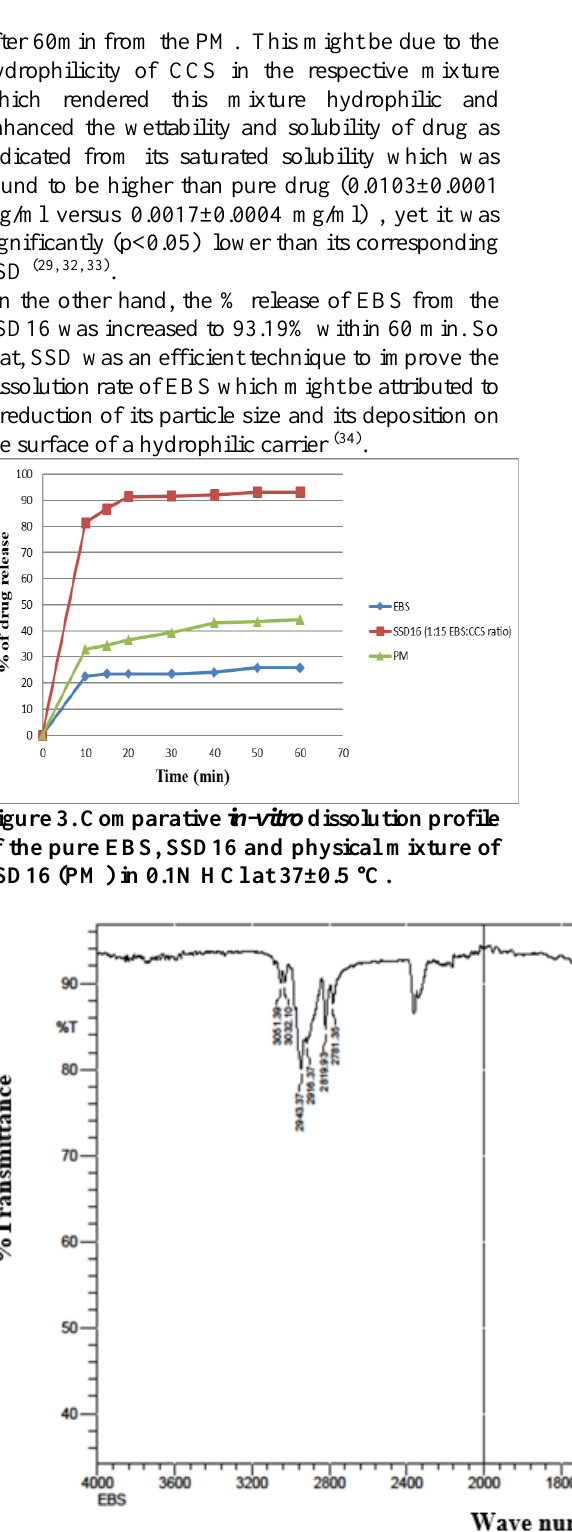
Figure 4 .FTIR spectrum of